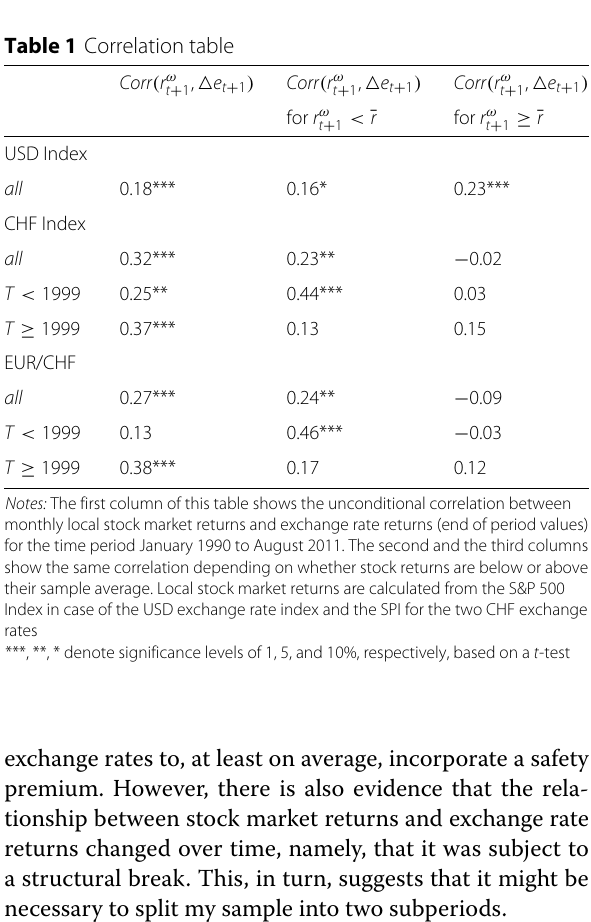
Fig. 2 ( a - c ) Rolling estimation of asymmetry equation. Notes: These figures present the results of the rolling estimations of the equation = α + β D + γ r ω + δ Dr ω + (cid:7) (cid:2) e t + 1 t + 1 , where D is a dummy t + 1 t + 1 equal to one when stock returns are below their sample average and zero otherwise. The window width is set to 100. The model is estimated by OLS, using Newey-West standard errors with 3 lags. The resulting estimates for the γ and δ coefficients are plotted in dark color at the mid-point of each window. The light lines represent the 90% confidence intervals